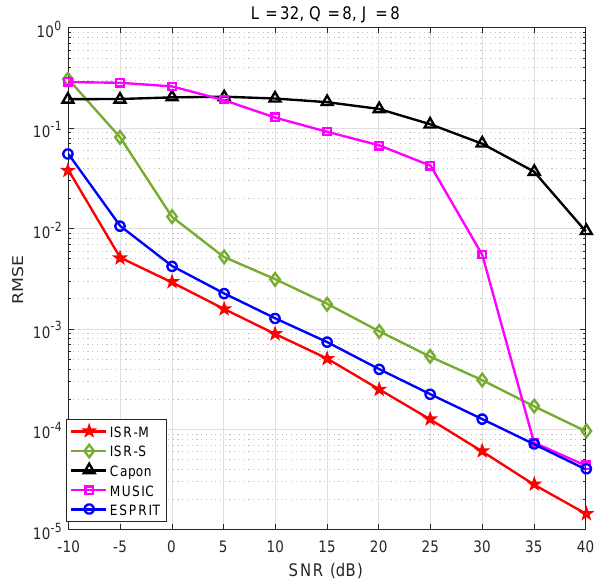
Figure 8. Comparison with existing MIMO radar target localization methods with K = 3, L = 32, Q = 8, and J = 8.